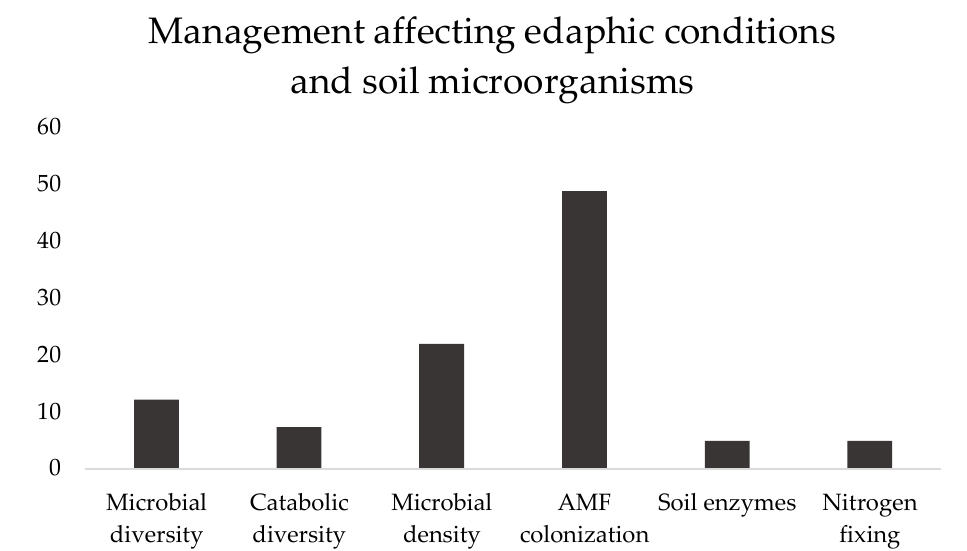
Figure 1. Subjects covered in the selected papers, in percentage, addressing the effect of management with different soil microorganisms, and in different edaphic conditions, between brackets. Microbial diversity [8,10,12,17,26], Catabolic diversity [10,11,27], Microbial density [9,15,17,19,22,23,25,28,37], AMF colonization [13,23,29–34,37–46,48,49], Soil enzymes [14,17], N 2 fixing [19,21].